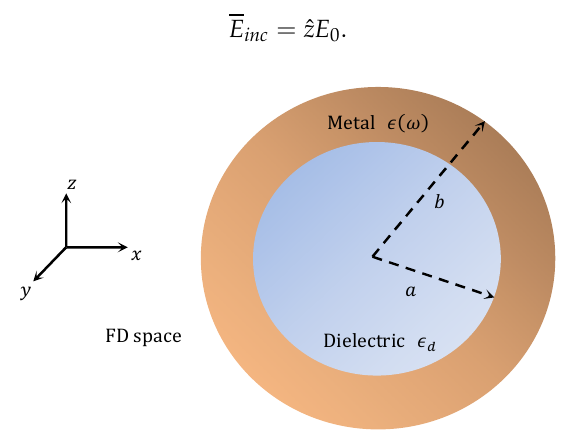
Figure 1. Schematic of the spherical shaped core-shell nanoparticle in the FD space.